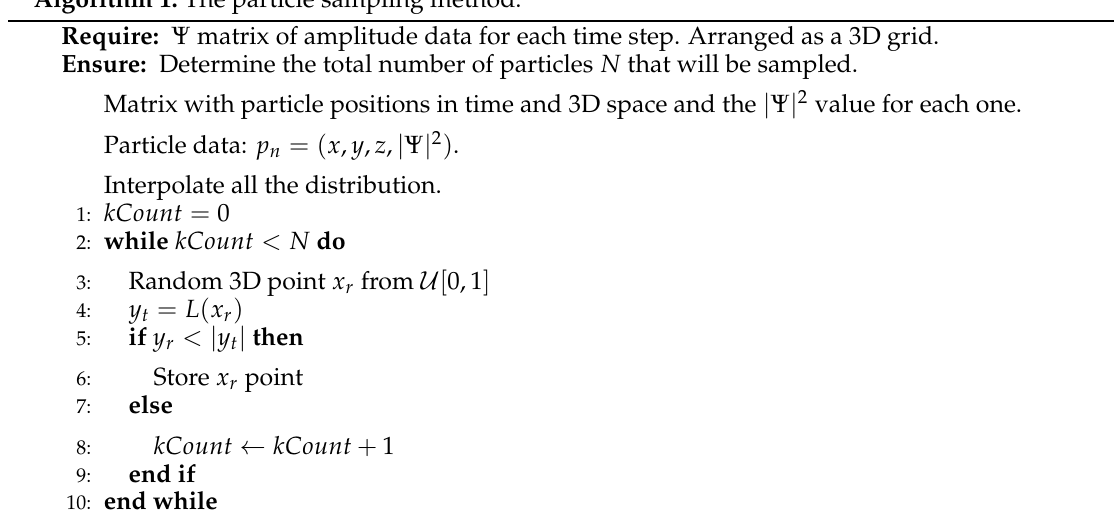
Algorithm 1: The particle sampling